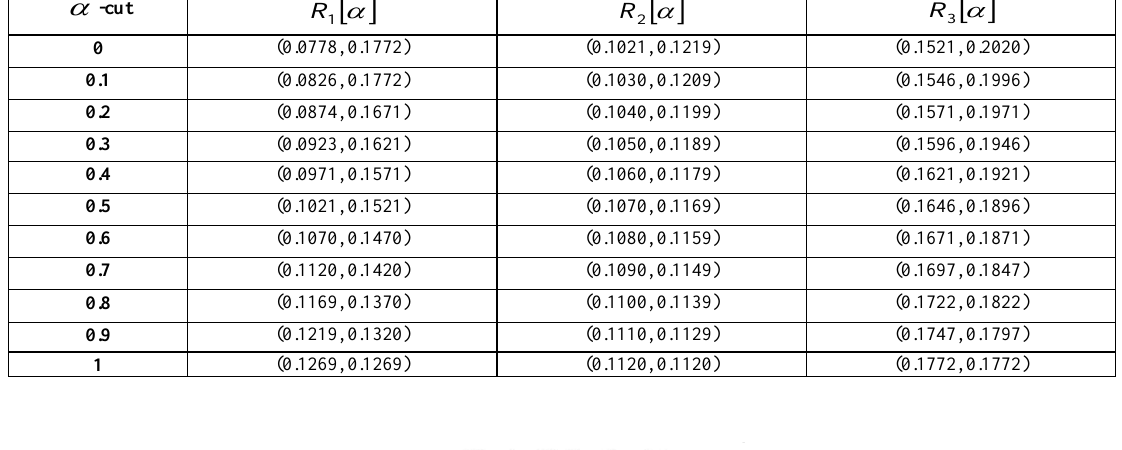
Table 1. Reliability of the linear system.